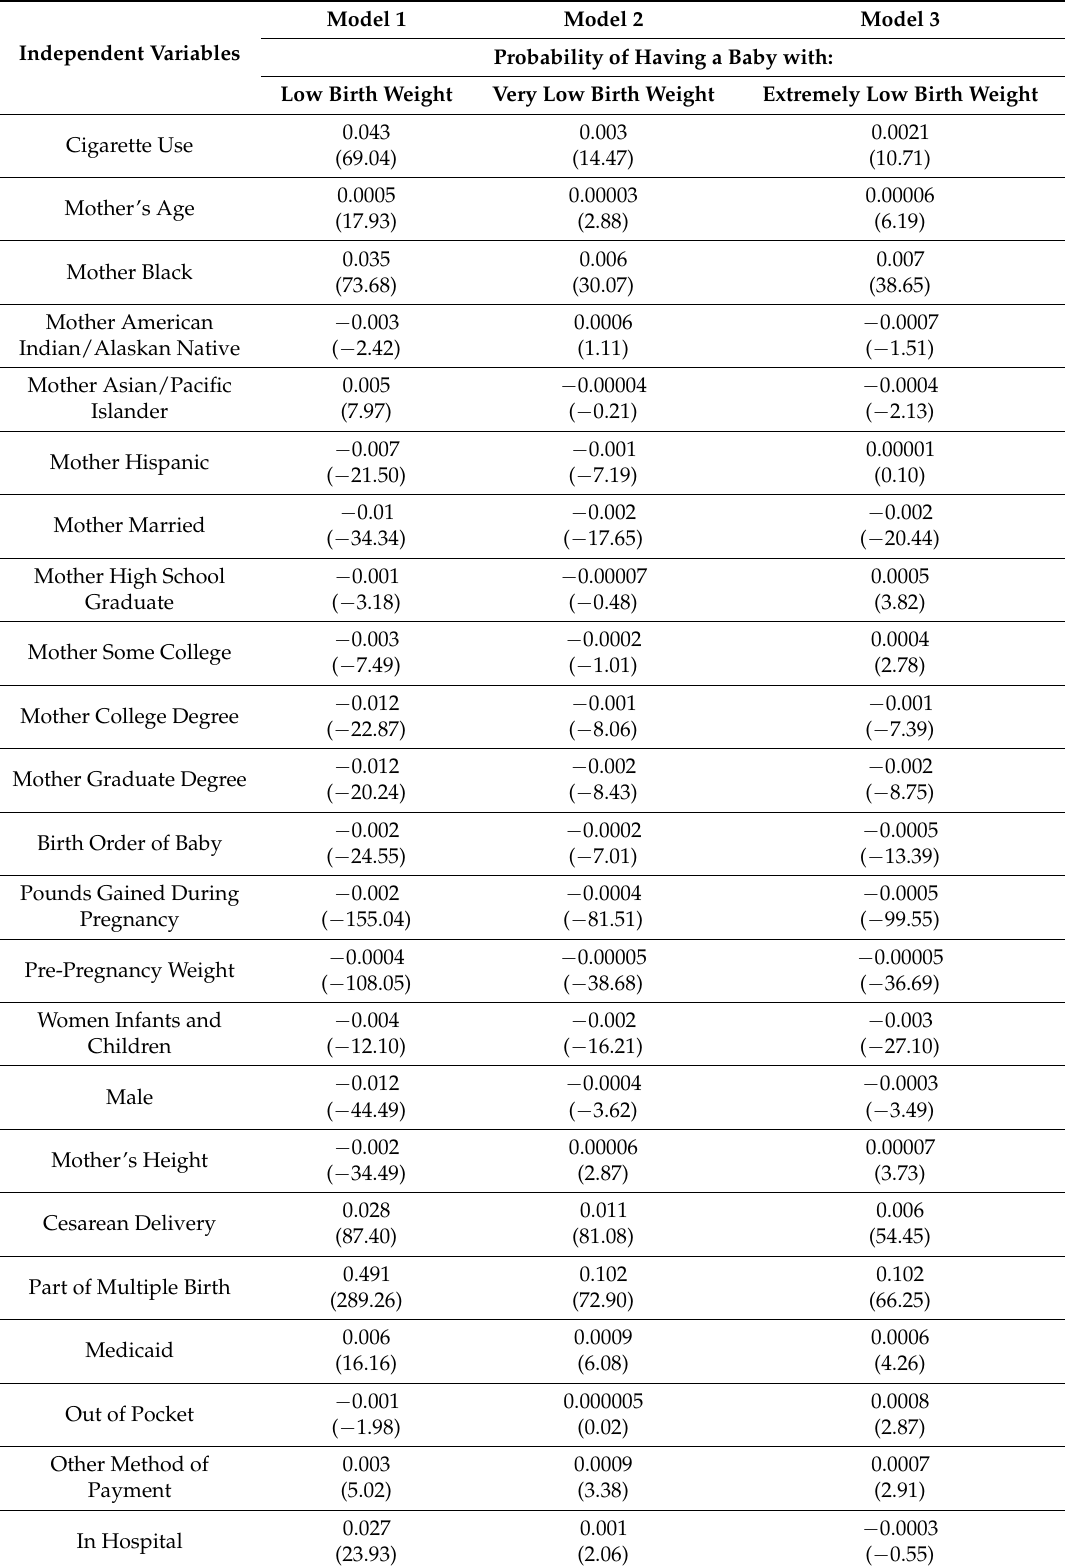
Table 1. Determinants of the probability of having a low, very low, or extremely low birth weight baby, expressed as marginal